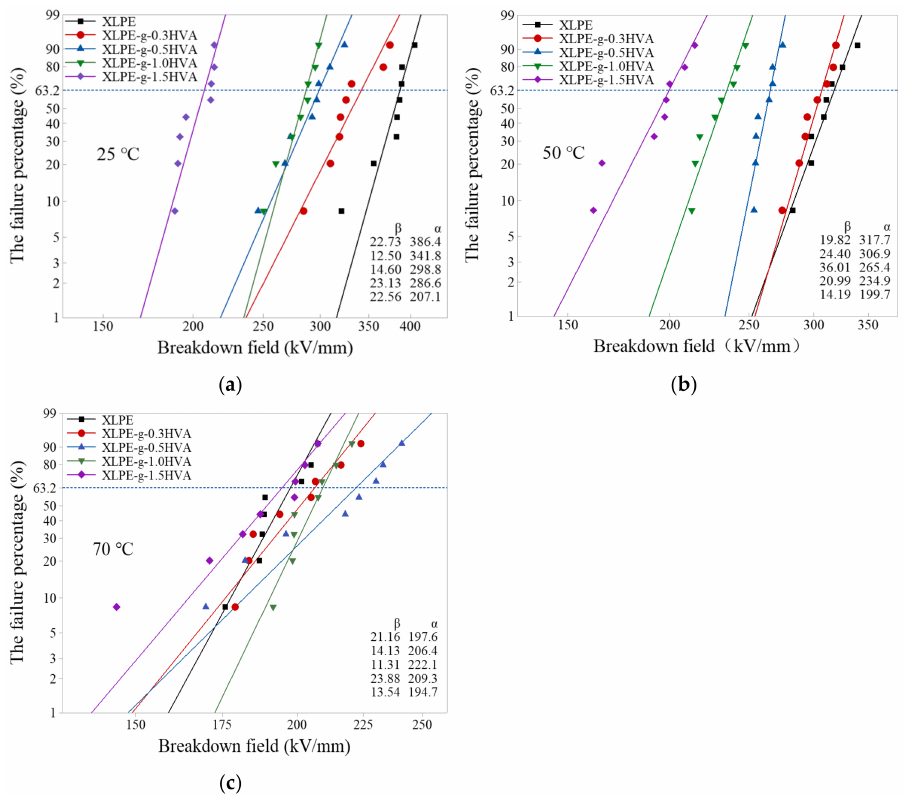
Figure 6. Weibull distributions of DC breakdown strengths of XLPE and HVA-2 grafted XLPE. ( a ) 25 ◦ C, ( b ) 50 ◦ C, and ( c ) 70 ◦